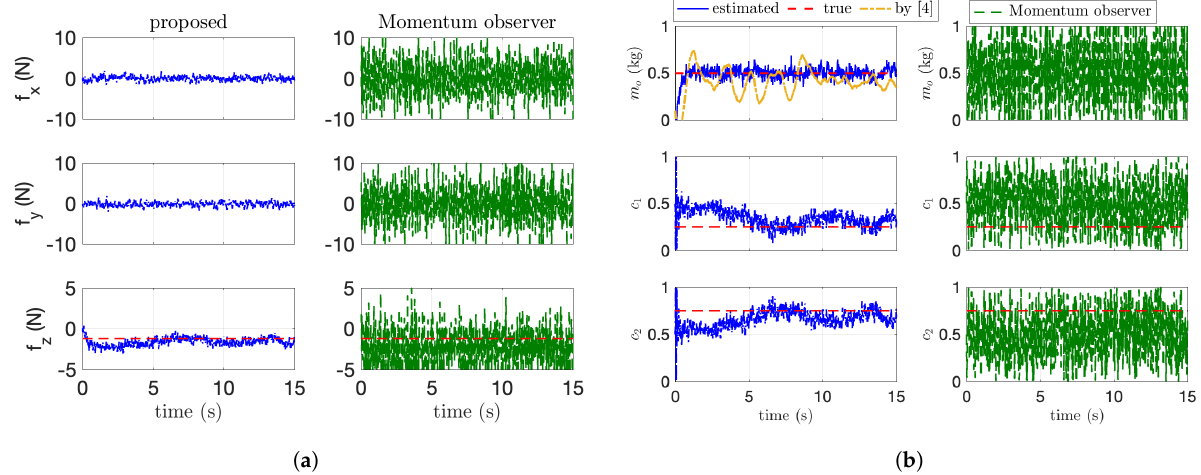
Figure 7. Dynamic parameter estimation. ( a ) Force estimation results. ( b ) Dynamic parameter estimation.